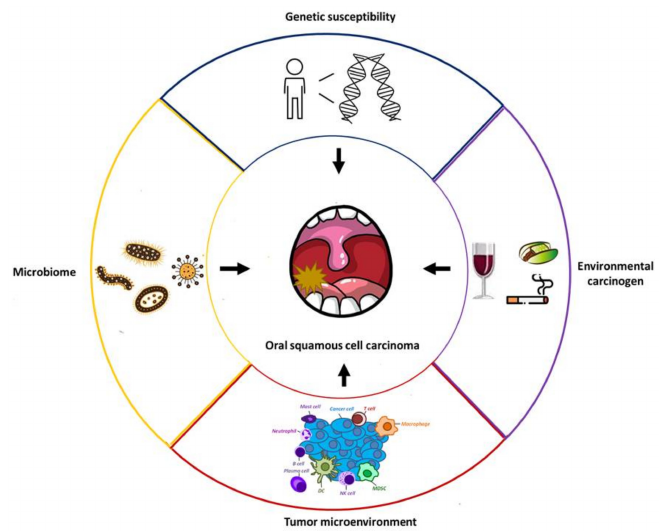
Figure 1. Major factors involving the formation of oral cancer. New insights into preventive, diag- nostic and therapeutic strategies for oral cancer may be derived through integrative investigations on these